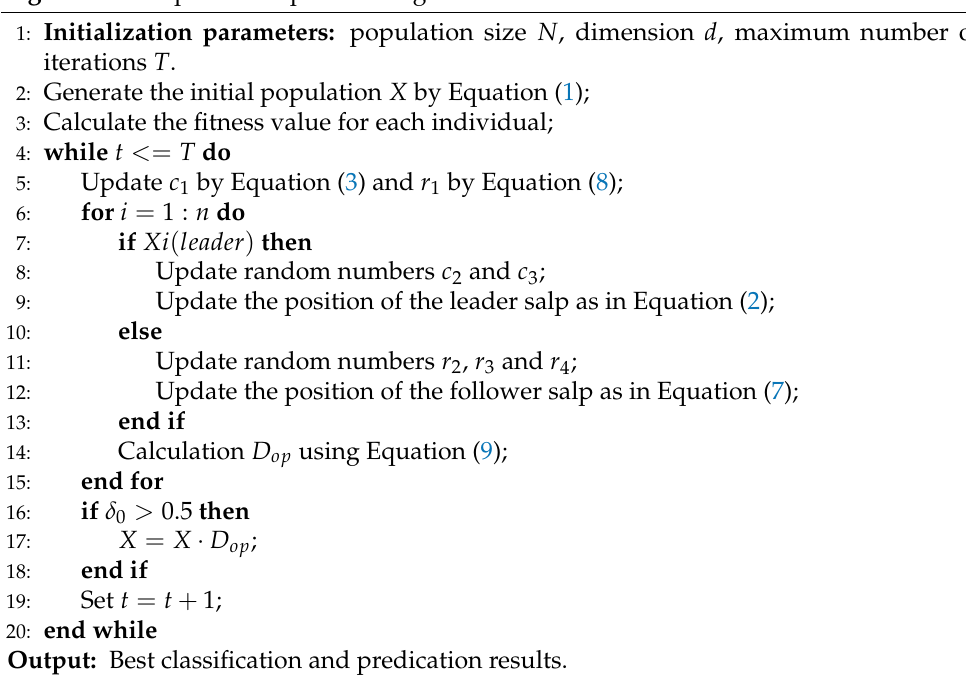
Algorithm 1 Improved salp swarm